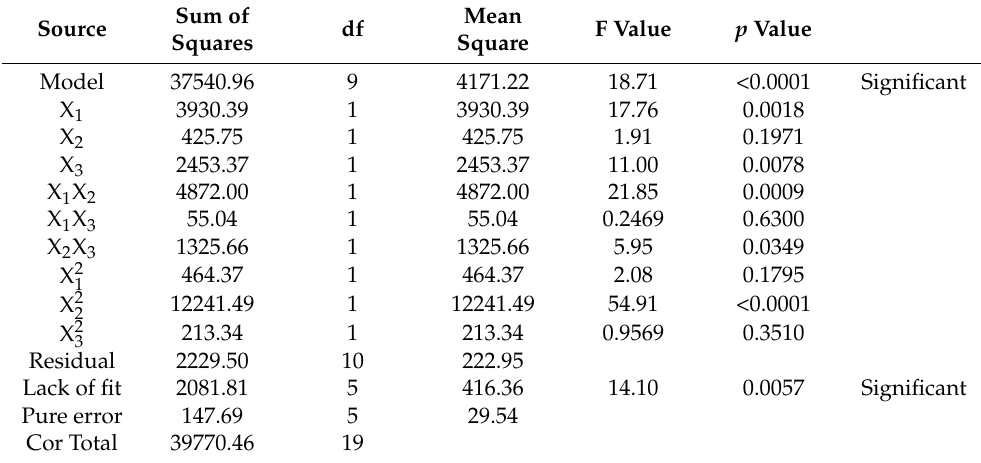
Table 3. ANOVA for model and respective model term: Density.